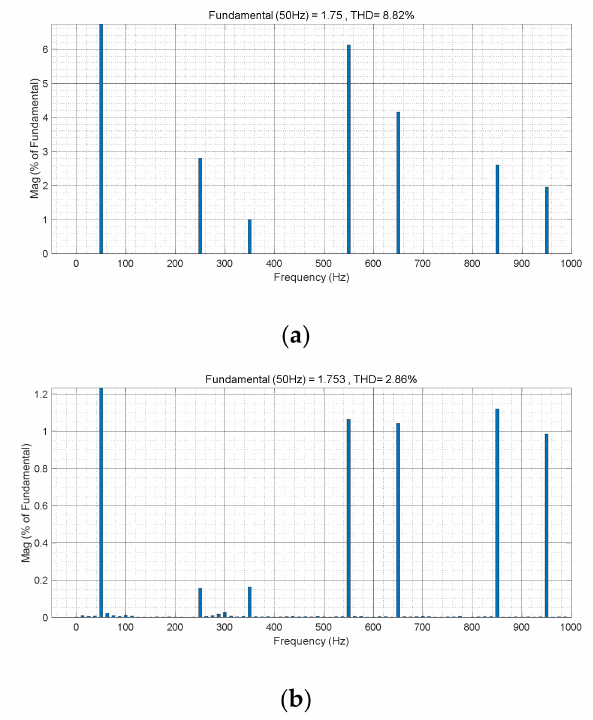
Figure 10. Distortion rate of the grid-side currents with and without the proposed HIAF system. ( a ) The distortion rate of the transformer’s grid-side winding current considering the 5th and 7th fully tuned filtering branches. ( b ) The distortion rate of the transformer’s grid-side winding current considering the proposed HIAF system.